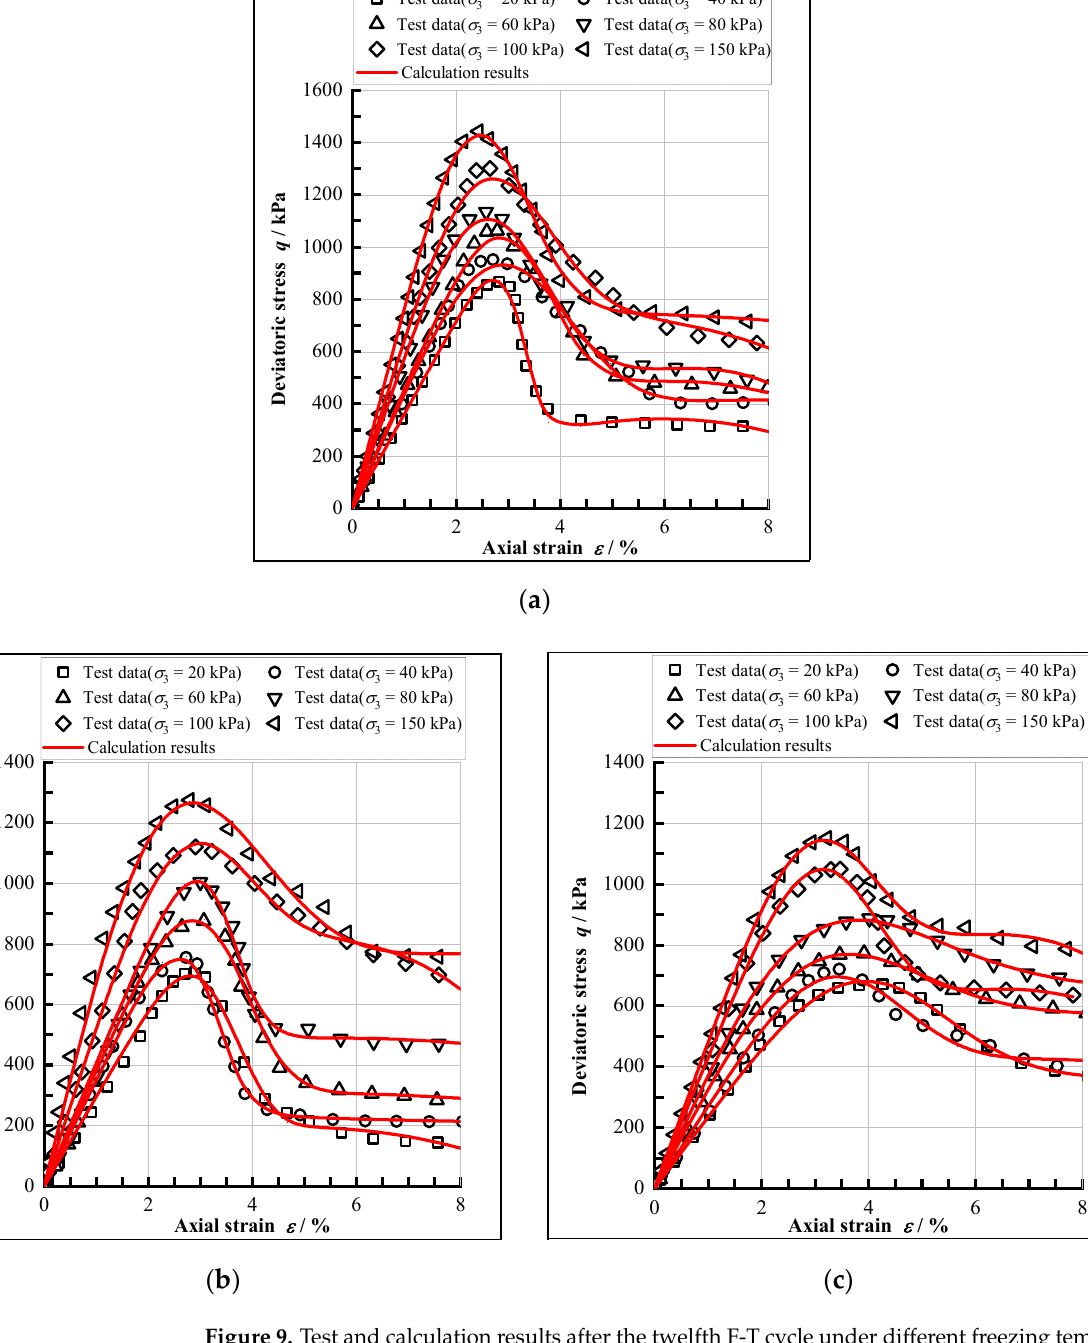
Figure 9. Test and calculation results after the twelfth F-T cycle under different freezing temperatures, ( a ) The freezing temperature is −5 °C, ( b ) The freezing temperature is −10 °C, ( c ) The freezing temperature is −15 °C.